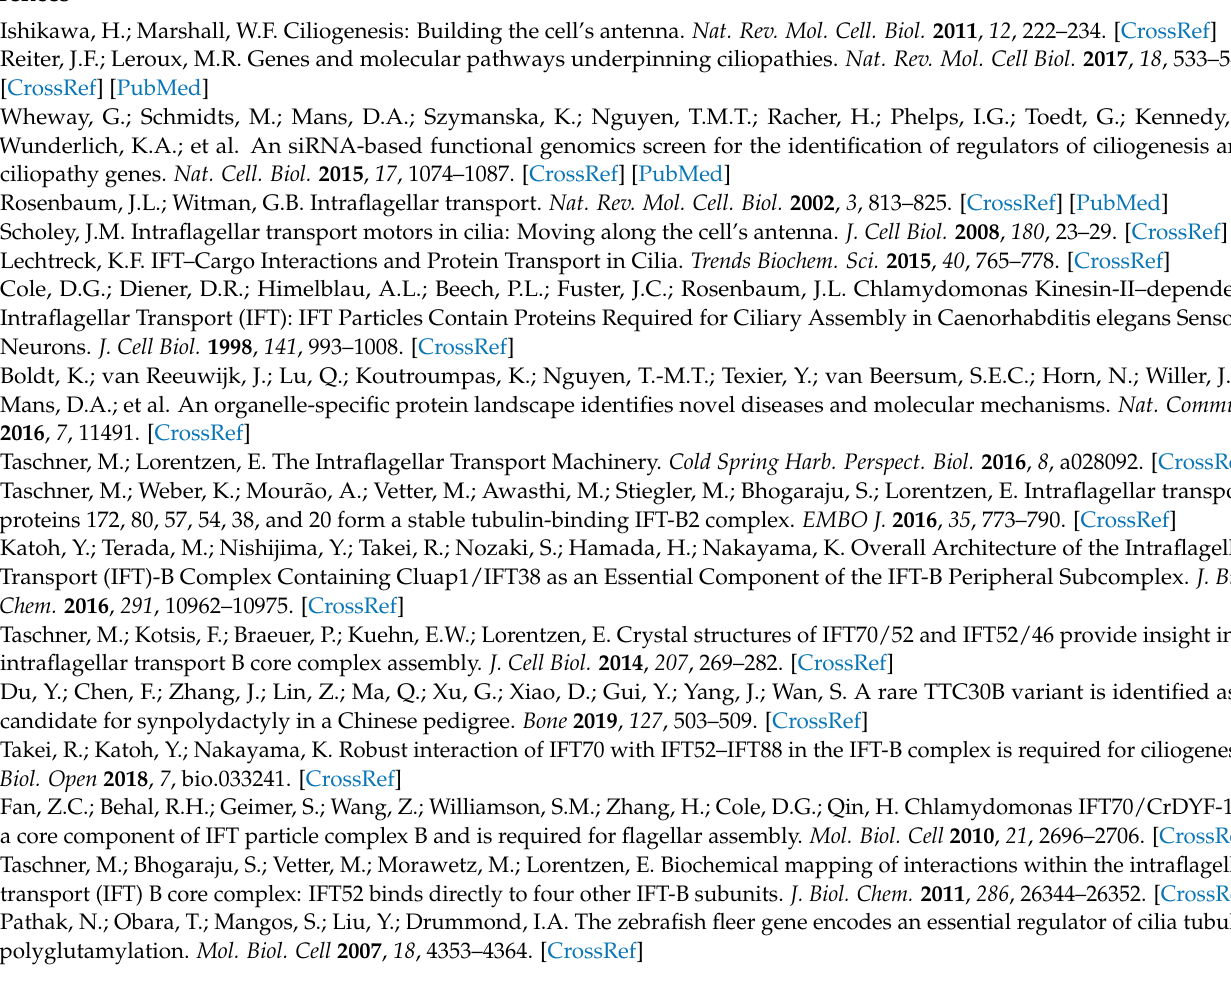
Figure S4: Protein level of IFT70/88/140 and acetylated Tubulin; Figure S5: Sequencing results for HEK293T TTC30A/B single and double KO; Figure S6: Localization of ARL13B and Rootletin